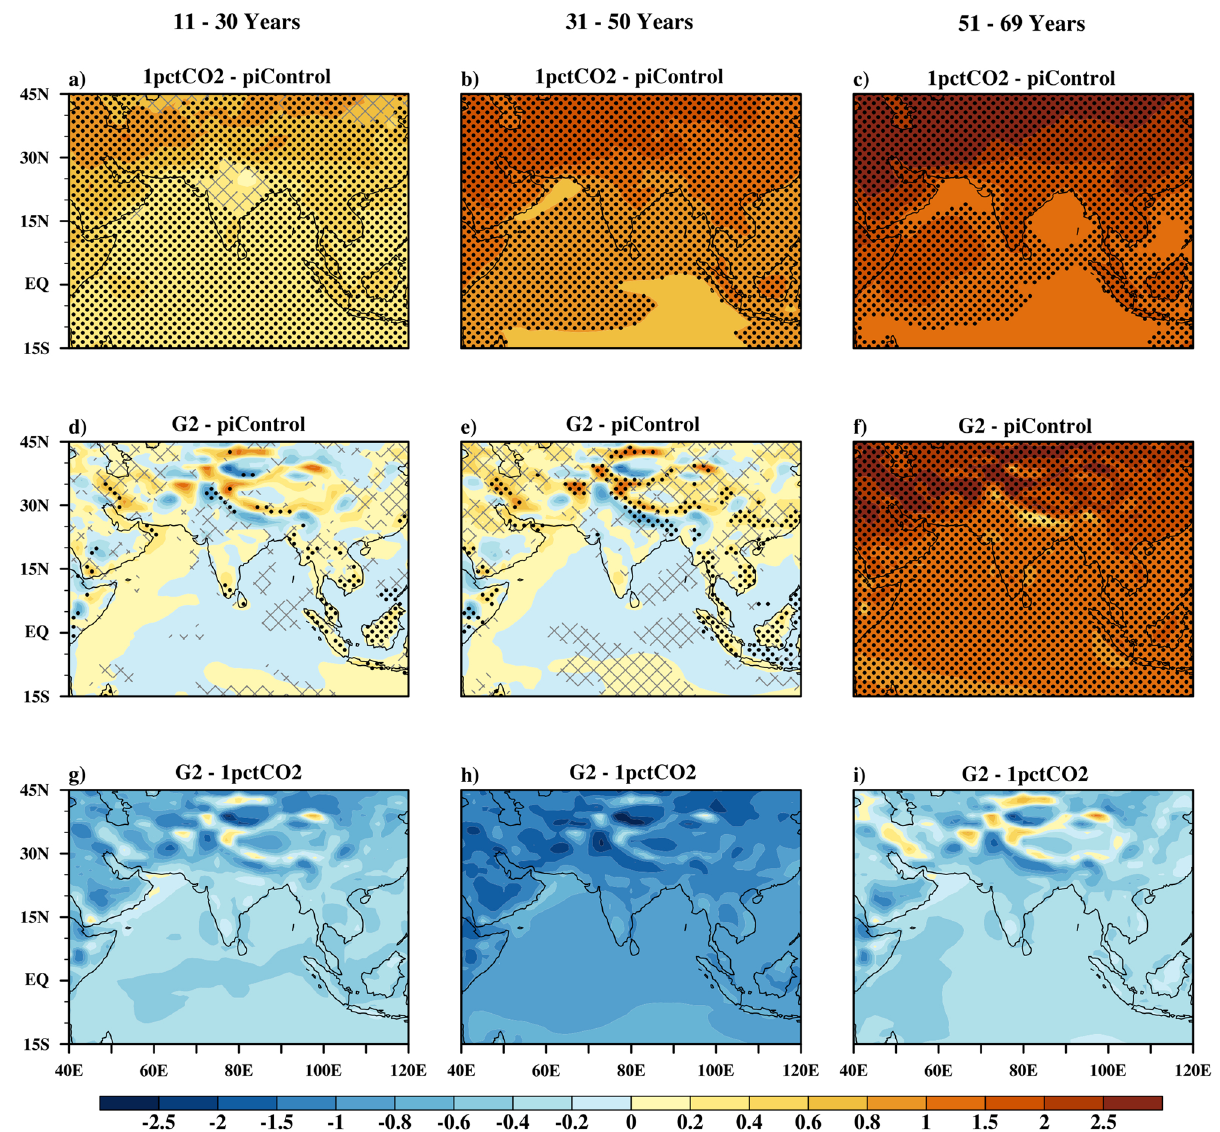
Figure 2. Multi model mean surface air temperature change ( 0 C) in the 1pctCO2 simulations (top row), G2 simulations (middle row) relative to piControl simulations for the Indian monsoon season (Jun-Sep) for three consecutive 20 year time periods. Bottom row shows differences between G2 and 1pctCO2. Hatching are the regions that have at least 70% model agreement. Stippling shows changes that are having at least 70% model agreement and also significant at the 95% confidence greater degree of cooling is projected over the Himalayan range than other parts of the ISM region, which may reduce Himalayan glacier melt 21 . Compared to the Indian land, projections over the subtropics are mixed and less conclusive. Similar to the Indian land, the areal extent of significantly cooler regions over ocean, increases with prolonged sustention of geoengineering. These different level of cooling over different regions may be attributed to the presence of inhomogeneous topographic surfaces. With abrupt termination of geoengineering (Fig. 2f,i), temperature over the ISM region rises at a higher rate than in the 1pctCO2 scenario. The warming over the subtropics reaches the 70-year value of the 1pctCO2 simulation within just 20 years. Over the Indian land and oceanic regions, warming after abrupt termination of geoengineering is 0.5—1 °C less than in the sub-tropical regions. This fast rate of warming of subtropical regions (consisting only of land regions) compared to tropical region (partly land and partly ocean) may be attributed to the faster rate of warming of land regions than oceanic regions. However, over tropical Indian land the fast rate of increase in temperature is partly compensated by the cooling effect caused due to increase in precipitation, so the rate of increase of temperature over Indian land is relatively slower than subtropical land.